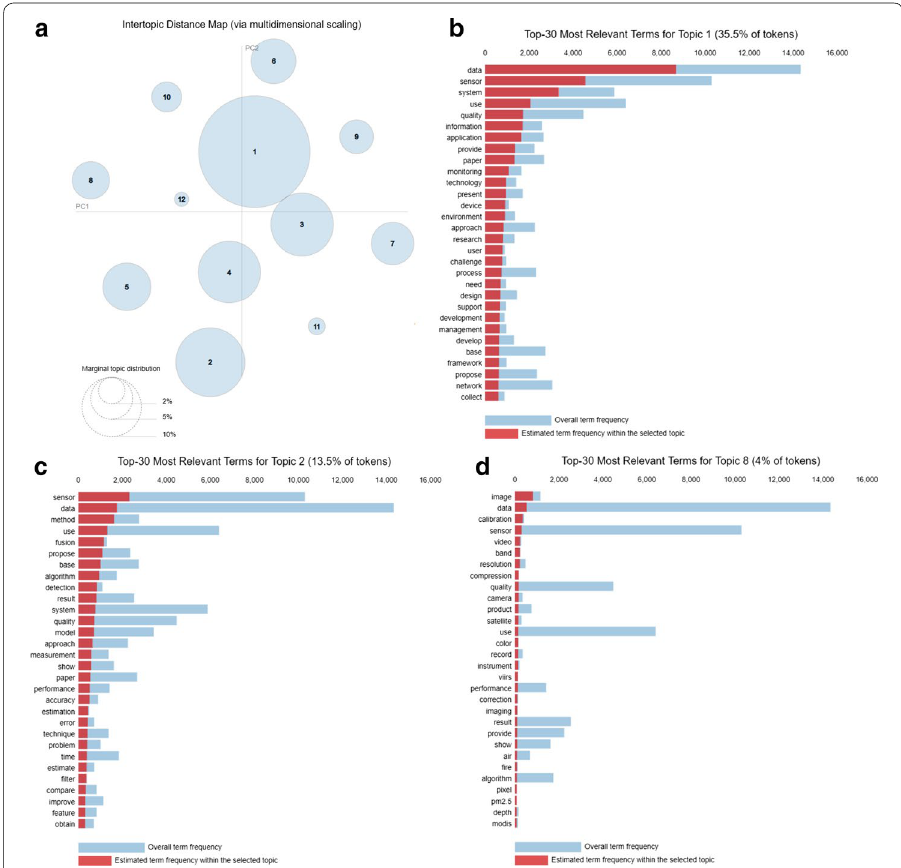
Fig. 2 Topic modelling with LDA. Topic model of 13,057 titles and abstracts found from the search string 1. Topic modelling is performed using a LDA model with 12 topics: a intertopic distance showing the marginal topic distribution of each topic, b – d top 30 most relevant terms for Topic 1, 2 and 8 respectively, along with its estimated term frequencies. Topic 1 and 2 have terms related to sensor and data, but Topic 1 is more focused on systems and applications whereas Topic 2 is associated with methods and algorithms. Topic 8 consists mostly of keywords related to imaging and satellite